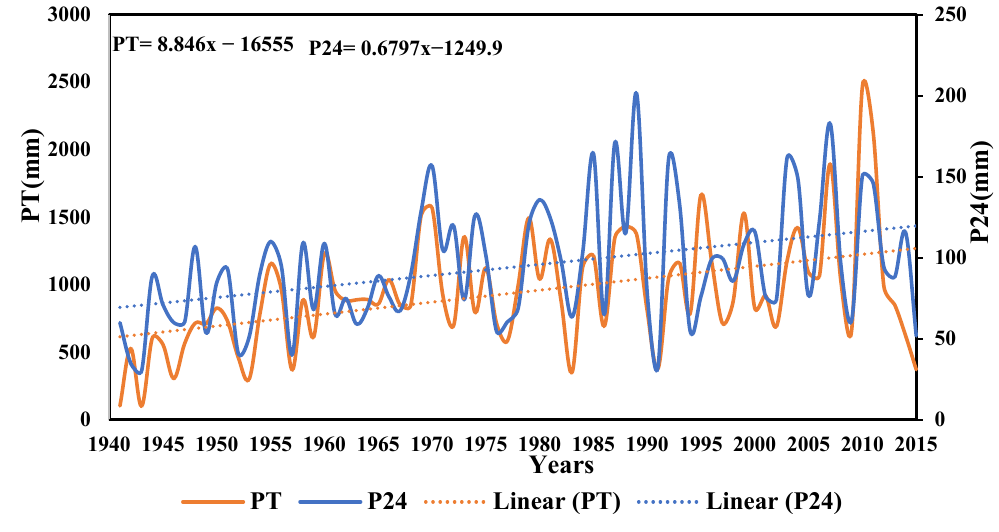
Figure 2. Representation of the IDEAM series for total precipitation in 24 h (P24) and for total annual precipitation (PT).